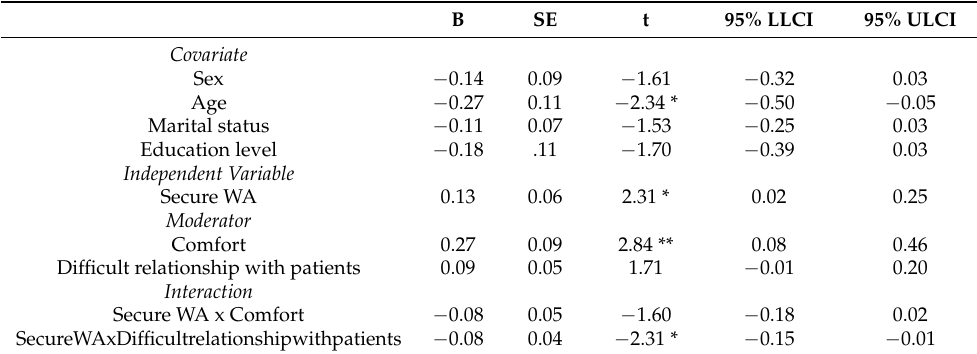
Table 3. Moderation model with secure WA as IV and Altruism as DV.